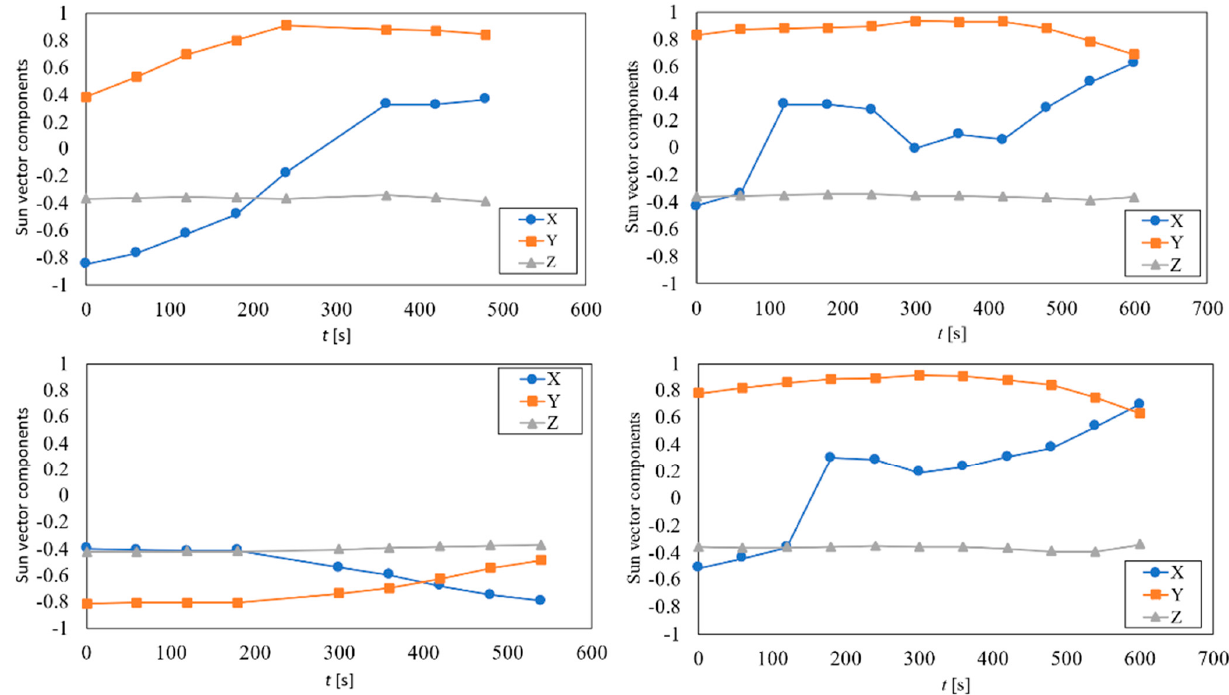
Figure 14. Calculated and filtered sun vector components for the illuminated accesses of the first three days of mission.